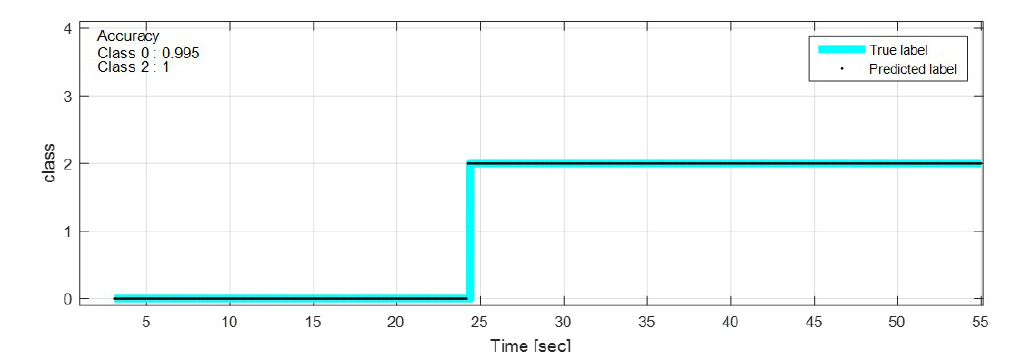
Figure 16. Prediction result on manhole and pothole road, 50